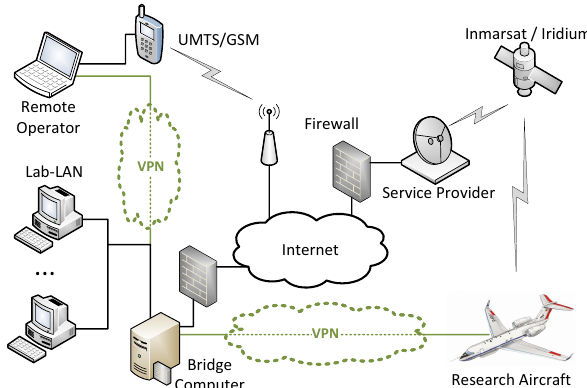
Figure 2. Global network topology diagram showing how the data transmission is carried out through VPN connection (shown in green) while transiting through the physical networks (shown in black). Here the logical (VPN) and physical networks are illustrated in parallel to highlight how they are perceived by the users. The op- erators at remote sites are fully integrated into the Lab-LAN through the VPN